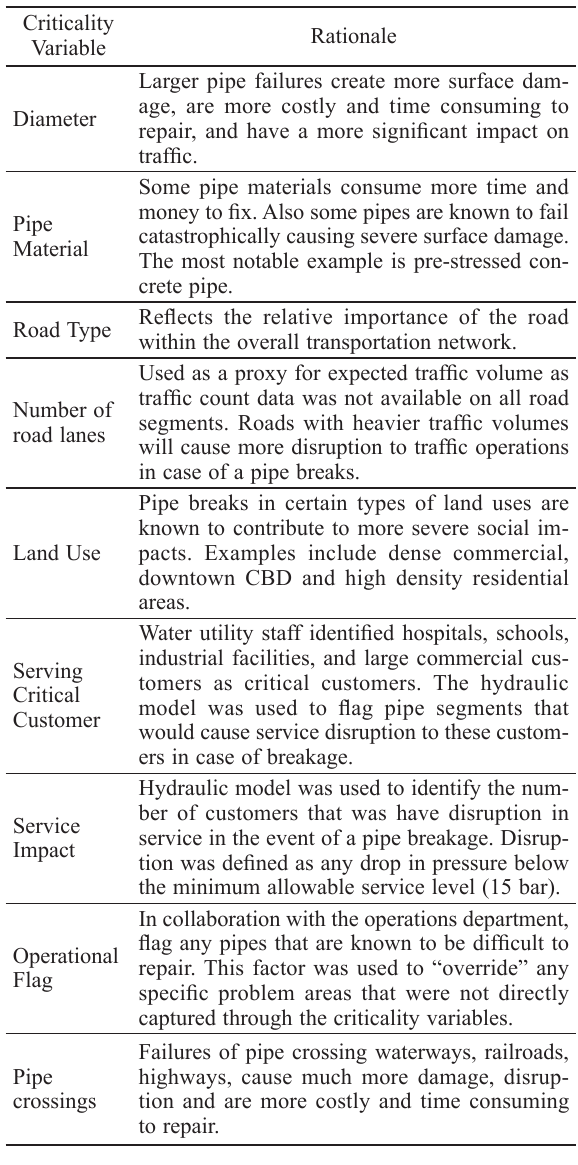
Table 1. Criticality variables